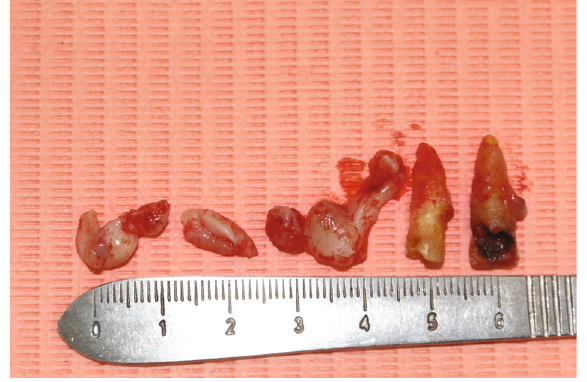
Figure 5: Gingiva removed from the lower left quadrant and extracted teeth (#33, #34, and #35).